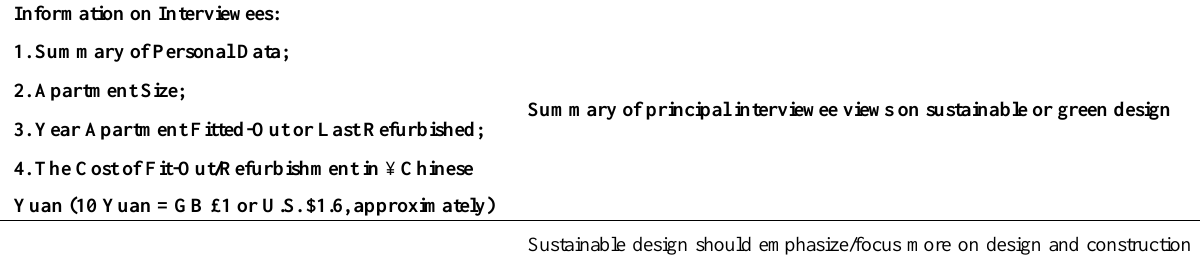
Table 1. Summary of interviewee data and views on sustainable/green